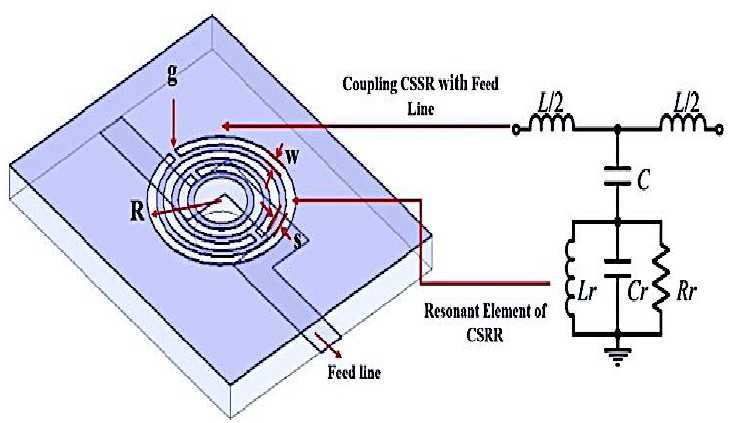
Figure 1. Curve-feed structure and its equivalent circuit.